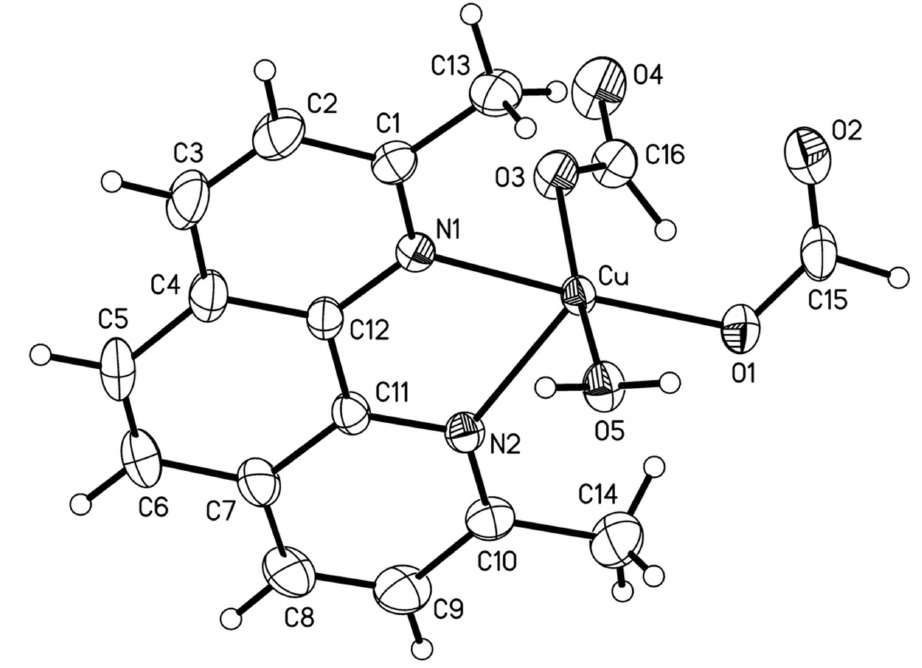
Figure 1 ORTEP view of the title compound. The displacement ellipsoids are drawn at 40% probability